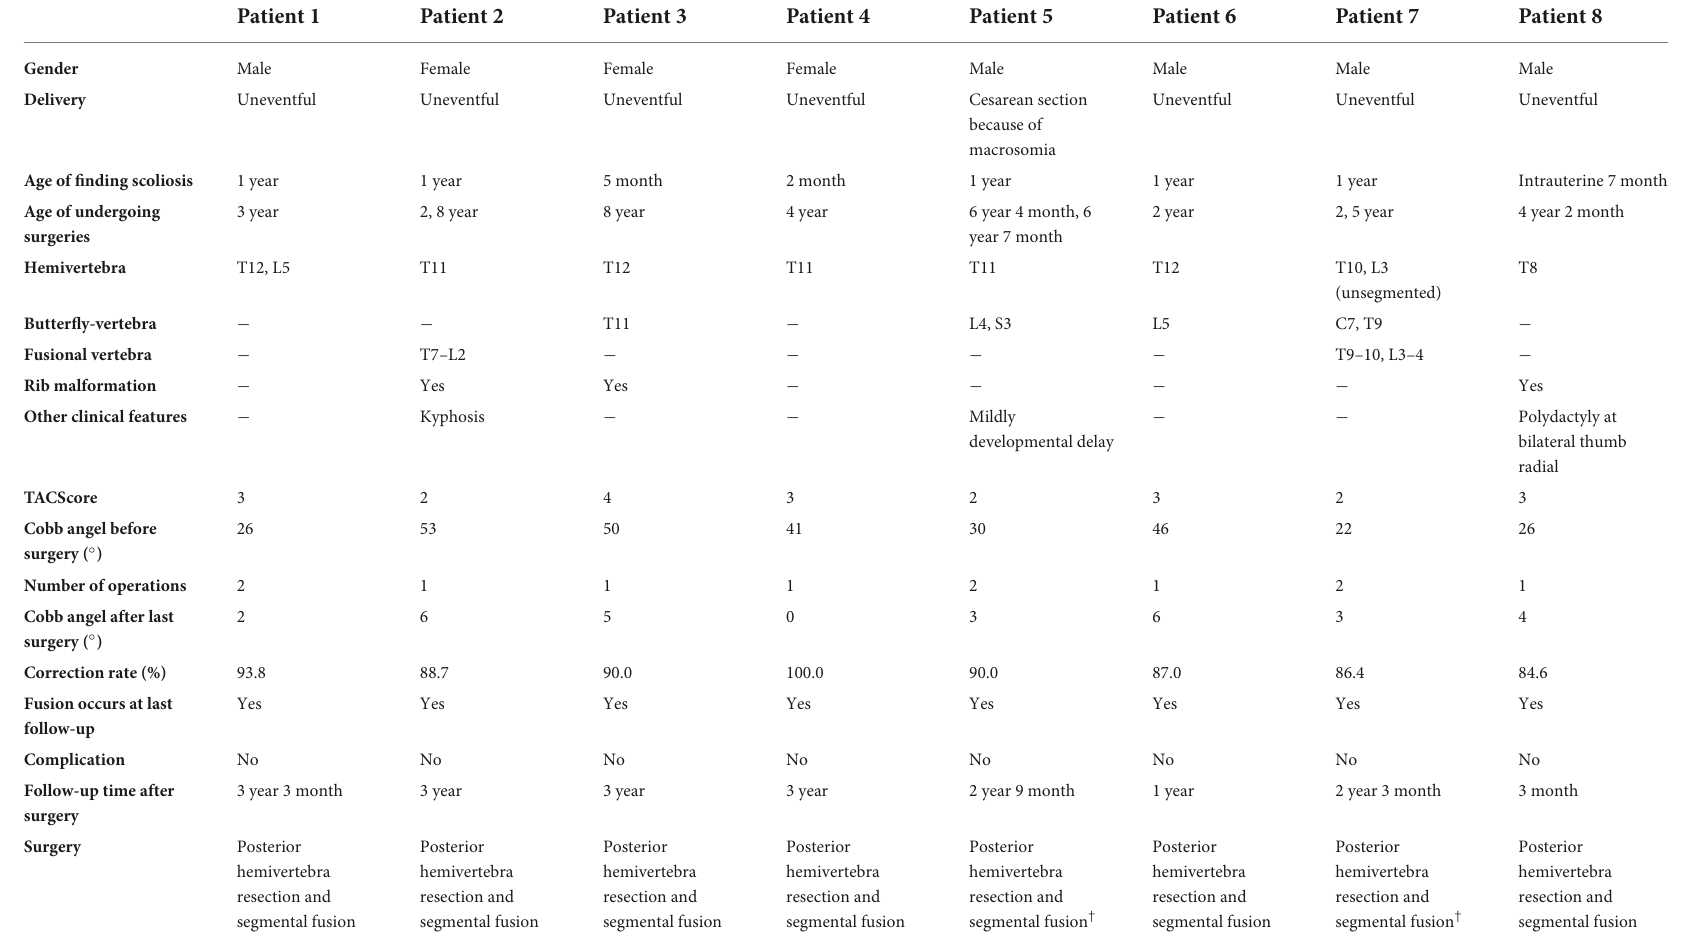
TABLE 2 Clinical information of